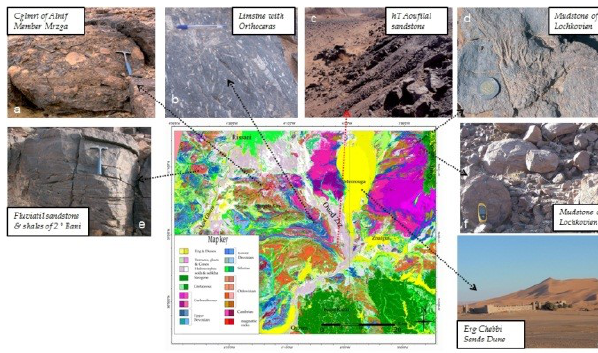
Figure13: samples used for validation with the ANN